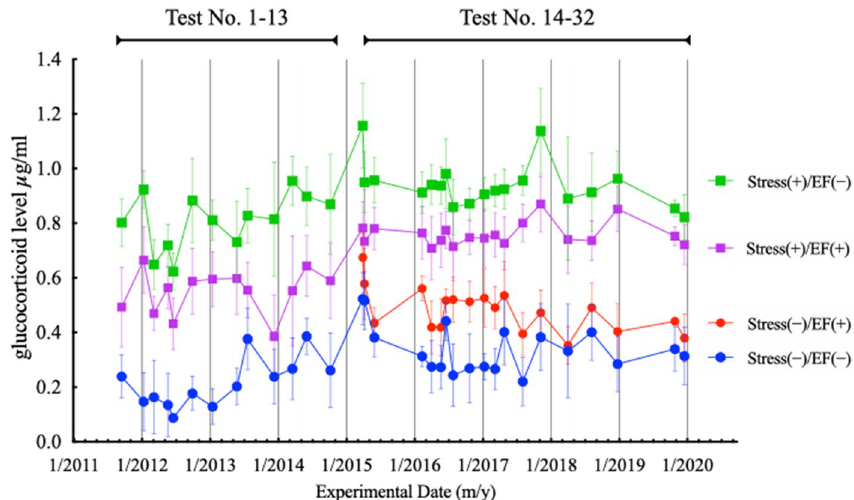
Figure 2. Effect of immobilisation and electric field exposure on immobilisation-induced increase in the plasma glucocorticoid level. Data of 32 tests conducted from 2011 to 2019 were pooled. The 32 tests included both published and unpublished data. The results are expressed as mean ± standard